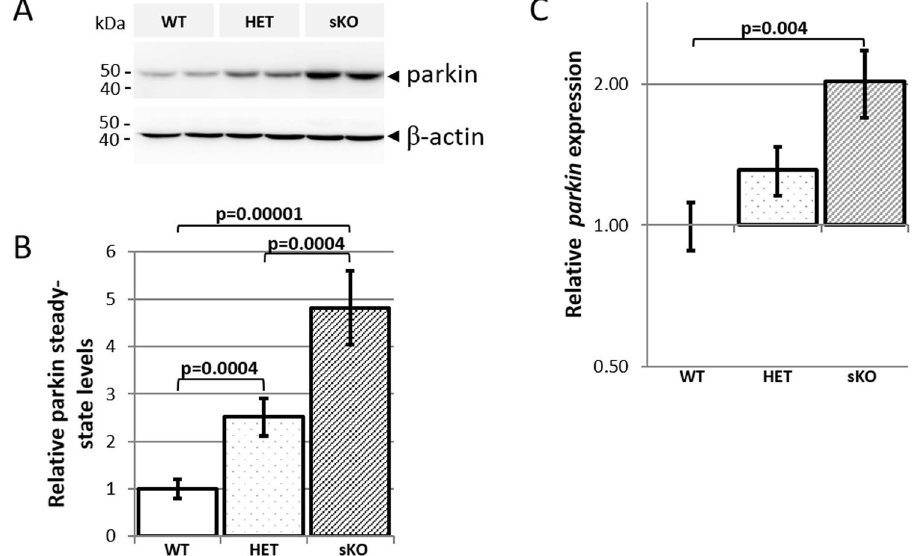
Figure 3. Single Pacrg knockout mice have increased parkin levels in the brain. Whole protein lysates from 8 week old mouse brains were used to determine the level of parkin in wildtype (WT), heterozygous (HET), and single Pacrg knockout (sKO) mice by western blot. ( A ) Representative western blot of parkin steady state levels in brain. The membranes were reprobed with an antibody directed against β -Actin to reference loading for digital quantitation of parkin steady state levels. ( B ) Mice (n ≥ 6/genotype) with the sKO allele have significantly increased parkin levels in the brain. ( C ) Quantitative RT-PCR was performed on RNA from 8 week old mouse brains to determine the level of parkin expression in WT, HET or sKO mice using exon spaning Taqman probes specific for parkin and Gapdh (control). Mice (n = 8/genotype) with two sKO alleles have significantly increased parkin expression. Error bars represent standard error of the mean. P values determined using the Student ’ s t-test (2 tailed, unequal